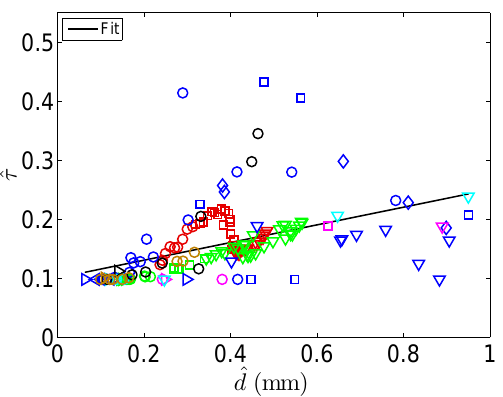
Figure 4. Estimated parameter pairs ( ˆ d , ˆ τ ) for all 167 samples. Experiment series are indicated by colors (TGM-17: red, TGM- 2: green, DIV: blue, DH-1: magenta, DH-2: cyan, ISO-1: black, ISO-5: brown) and snow types by markers (PP: (cid:67) , DF: (cid:66) , RG: ◦ , FC: (cid:3) , DH: ∨ , MF: (cid:5) ).